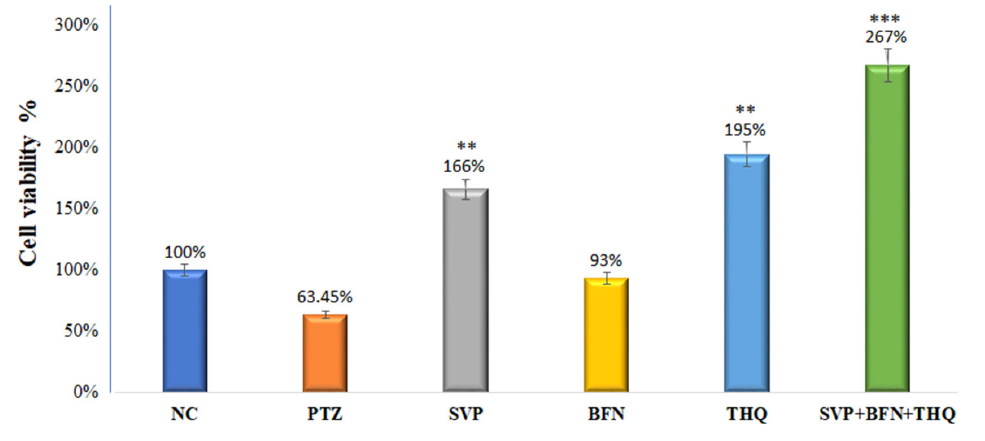
Figure 8. % cell viability of HEK-293 cells by MTT assay. The cells were first exposed to PTZ (0.6 µ g/mL), and later with different concentrations of SVP (120 µ g/mL), BFN (1.50 µ g/mL), THQ (12.0 Figure 7. % cell viability of HEK ‐ 293 cells by MTT assay. The cells were first exposed to PTZ (0.6 µ g/mL) and SVP + BFN + THQ (120 + 1.5 + 12.0 µ g/mL) for 24 hr. The % of cell viability is given μ g/mL), and later with different concentrations of SVP (120 μ g/mL), BFN (1.50 μ g/mL), THQ (12.0 in the graph is taken from the dose which gives the highest percentage of cell viability. ** p < 0.01, *** p <